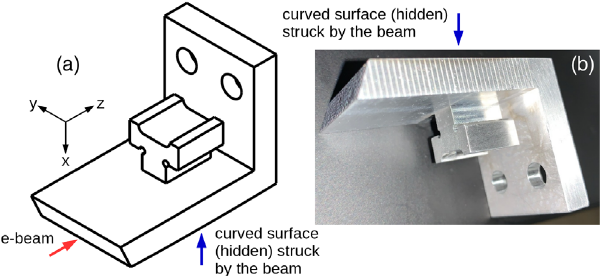
FIG. 12. Collimator test piece. (a) Oblique view. (b) The manufactured article showing 1-mm-spaced rulings along one of the lateral surfaces. Distance along the chord on the beam- facing surface is 41.5 mm.